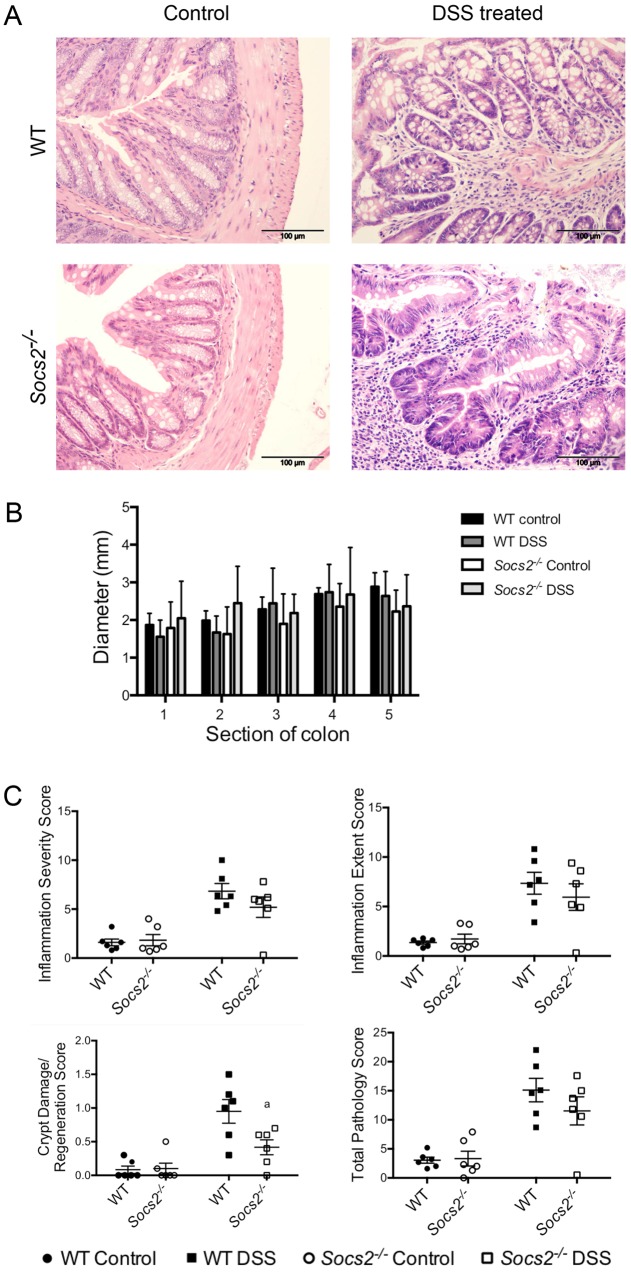
Colon pathology of DSS-treated WT and Socs2−/− mice. (A) Representative H&E-stained sections of colon from control and DSS-treated WT and Socs2−/− mice. (B) Diameter of DSS-treated and control WT and Socs2−/− colons. Numbers 1-5 represent different segments along the colon. (C) Histological scoring of DSS-treated and control WT and Socs2−/− colons. Data are presented as means±s.e.m. (n=6). aSignificantly different from DSS-treated WT mice (P<0.05) by unpaired t-test or nonparametric test (Mann–Whitney).